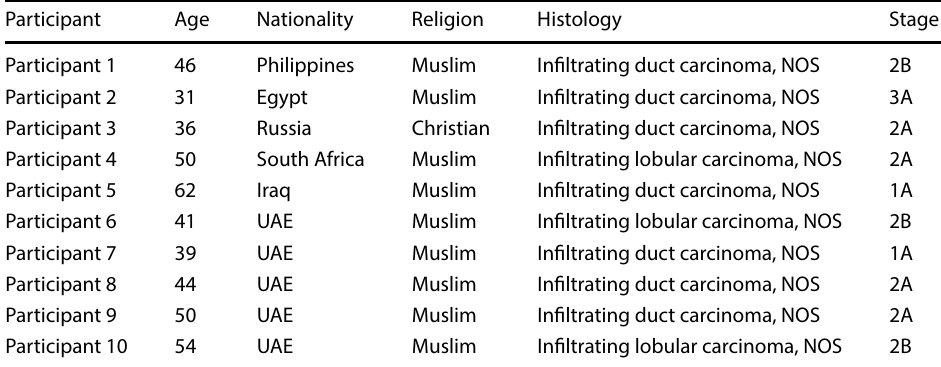
Table 1 Details of the study